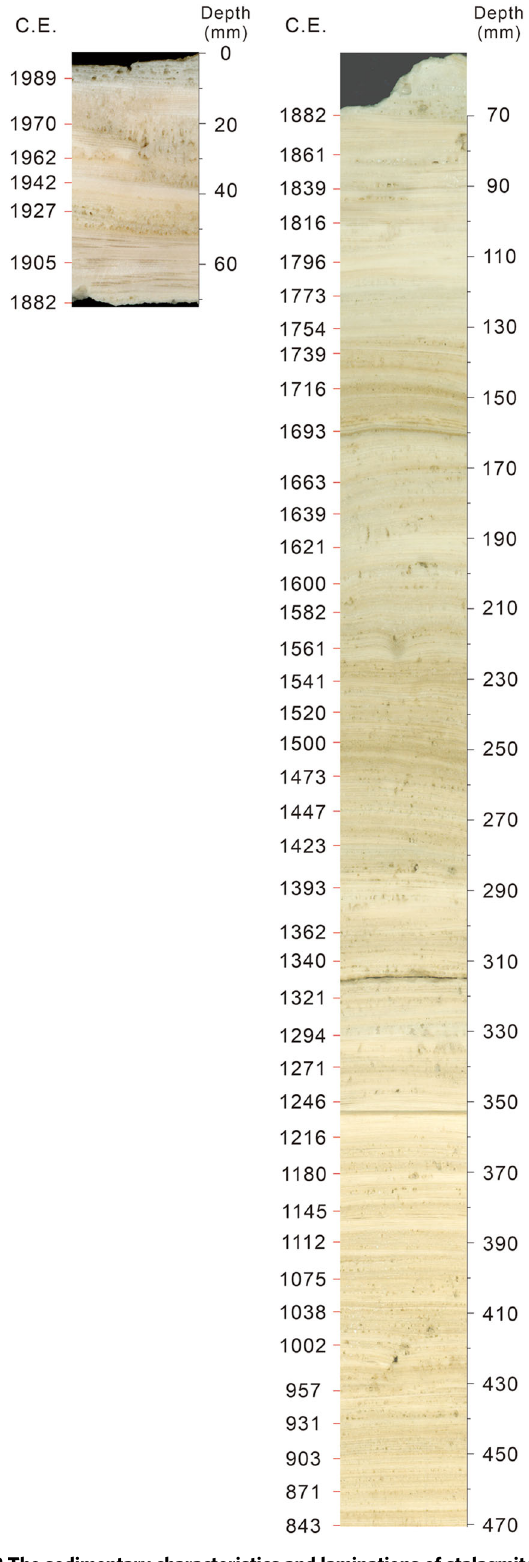
Fig. 2 The sedimentary characteristics and laminations of stalagmite HS4 from Heshang cave in the recent 1150 years. The section consists of two broken parts (the top 7 cm and the rest 40 cm). The numbers along the right and left edges mark the depth and chronology of HS4. Annual- resolved carbonate powder samples were scraped year by year for δ 18 O